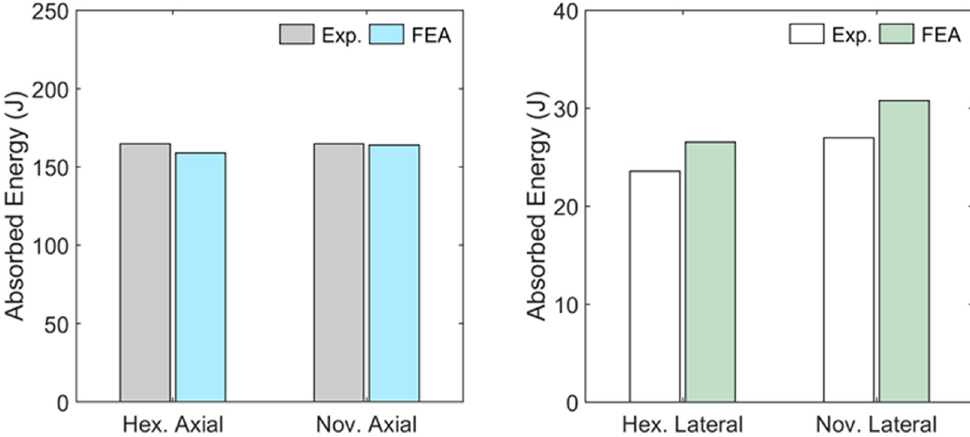
Figure 24. Comparison of the amounts of energy absorbed for novel and hexagonal cells, along the